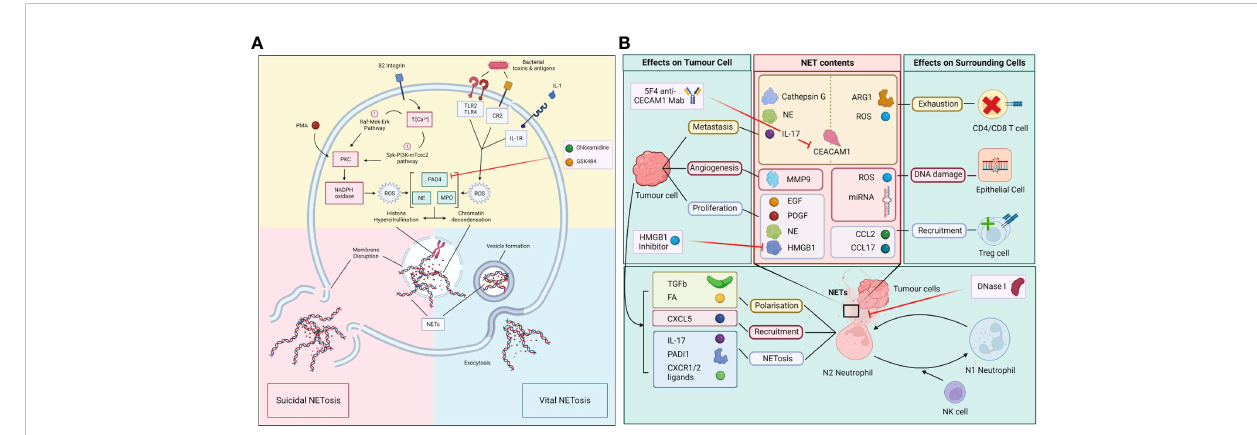
FIGURE 1 (A) Molecular process of vital and suicidal NETosis. The two forms of NETosis include suicidal NETosis and vital NETosis. Suicidal NETosis involves the dissolution of the plasma membrane while vital NETosis preserves the membrane with exodosis of NETs via vesicles. The two pathways converge upon the activation of PAD4, NE and MPO which leads to histone hypercitrullination, chromatin decondensation, the formation of NETs and the disruption of nuclear membrane. (B) Polarization of N1/N2 neutrophils in the tumour microenvironment (TME) and the effect of NETs on tumour and surrounding cells. Neutrophils in the TME are polarized towards either N1 or N2 phenotypes, which is determined by the in fl uence of factors produced by surmunding NK cells and tumour cells. N2 neutrophils that undergo NETosis release a myriad of molecules and enzymes that have immunosuppressive and pro-tumour properties as well as causing damage to surrounding epithelial cells. In turn tumour cells release various factors that induce the polarization, recruitment, and trigger NETosis in N2